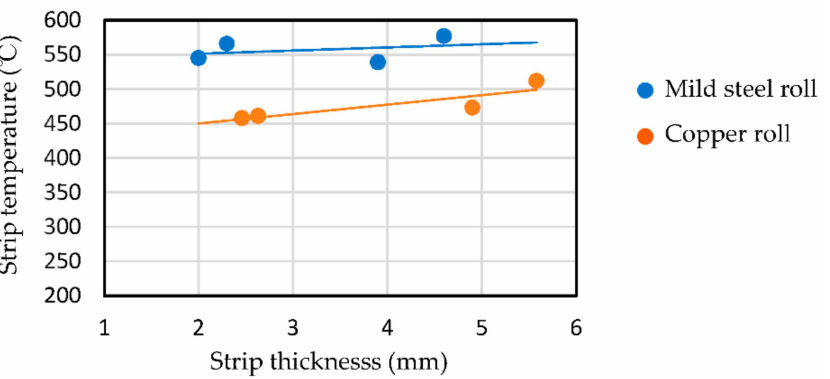
Figure 11. Effects of roll materials on relationship between strip temperature and strip thickness at roll bite obtained from Figures 4 and